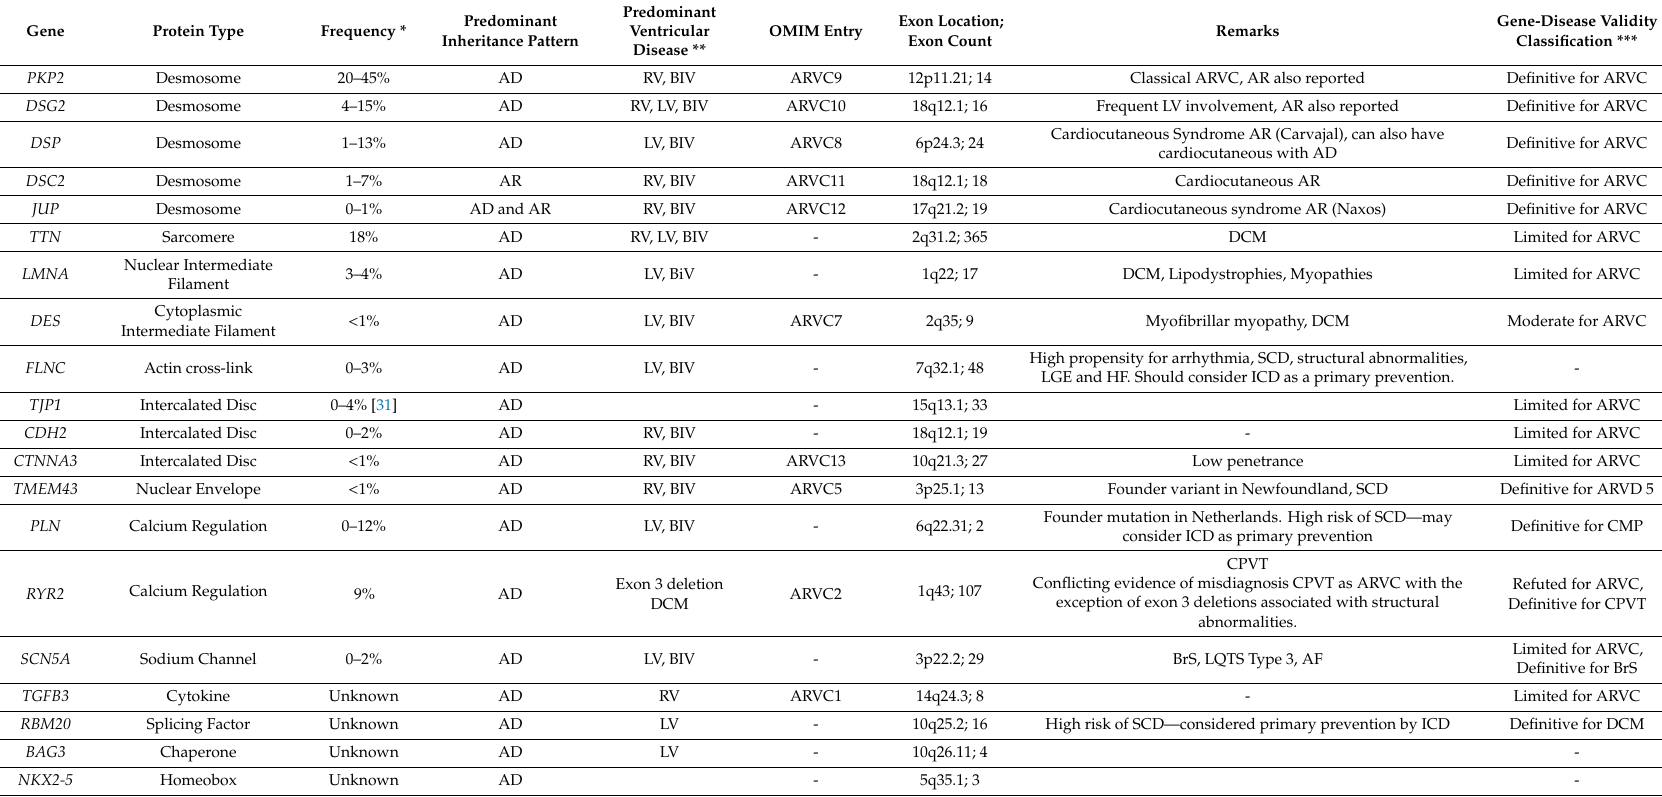
Table 2. Summary table for the genes implicated in